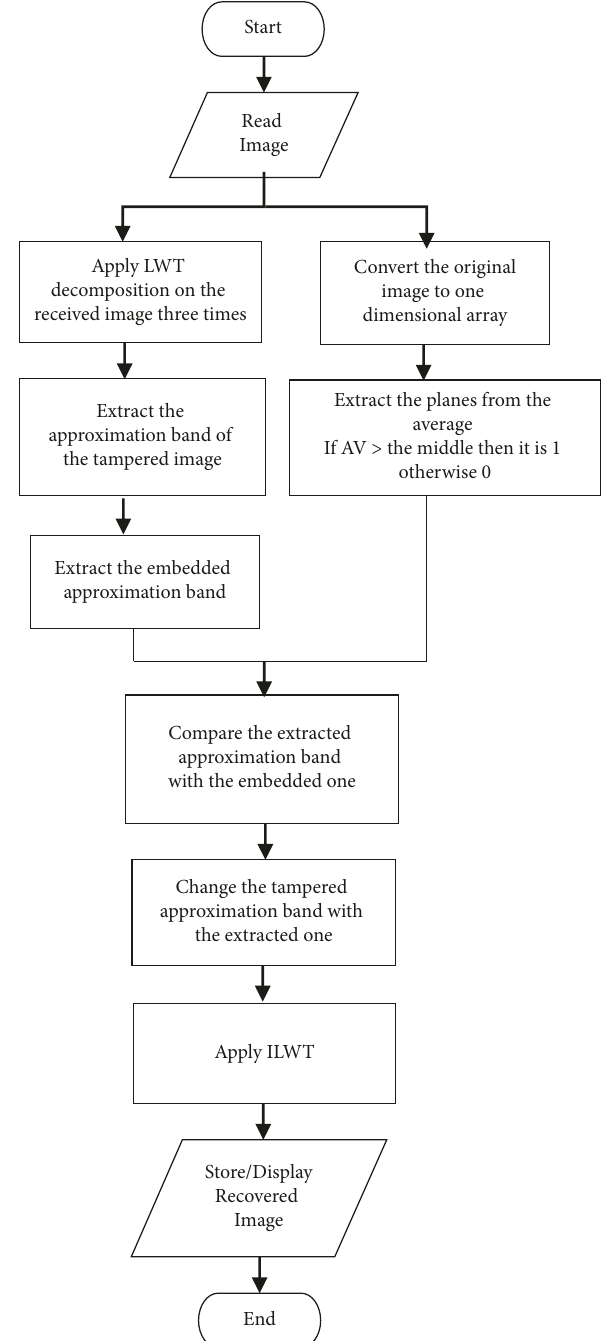
Figure 7: Recovery